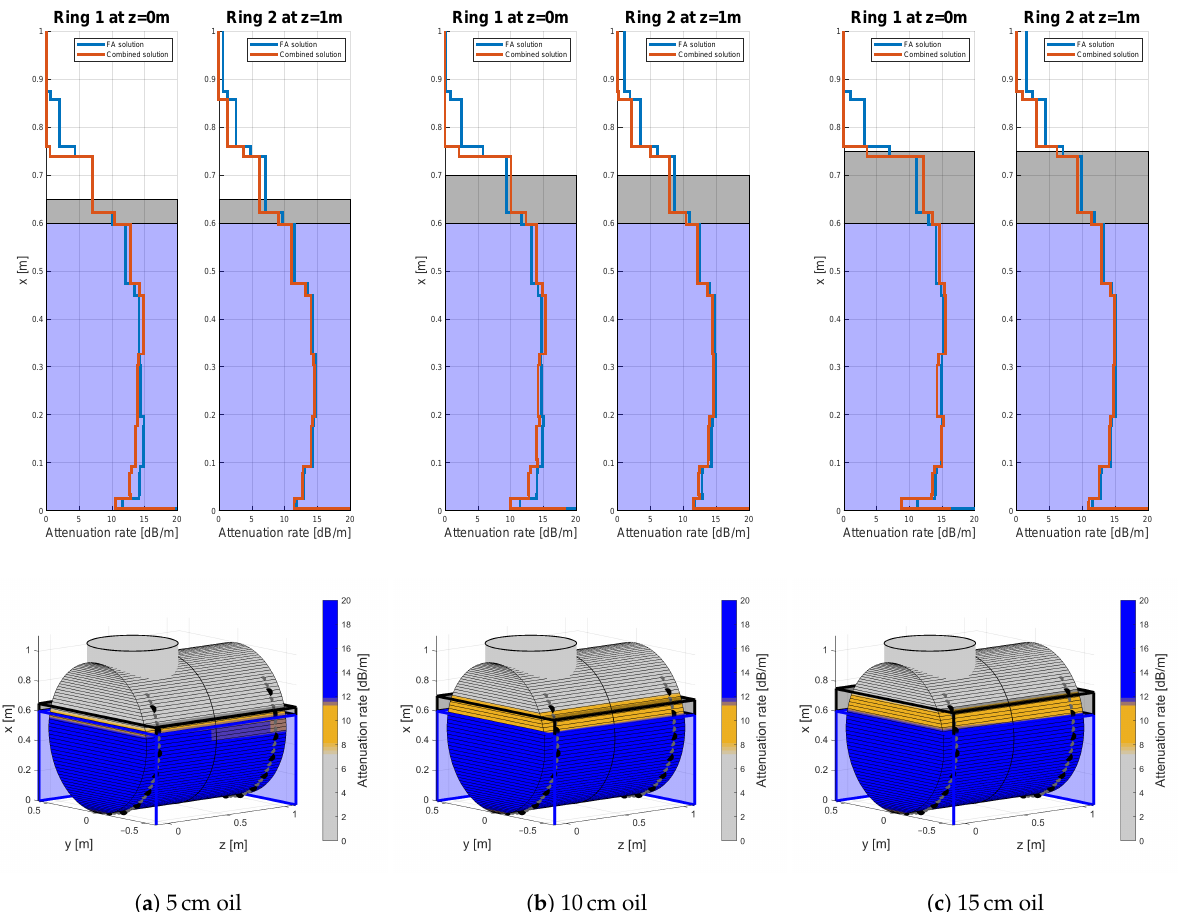
Figure 9. Results for three different oil fillings, 60cm water filling, an excitation frequency of 100kHz and 15cm sensor